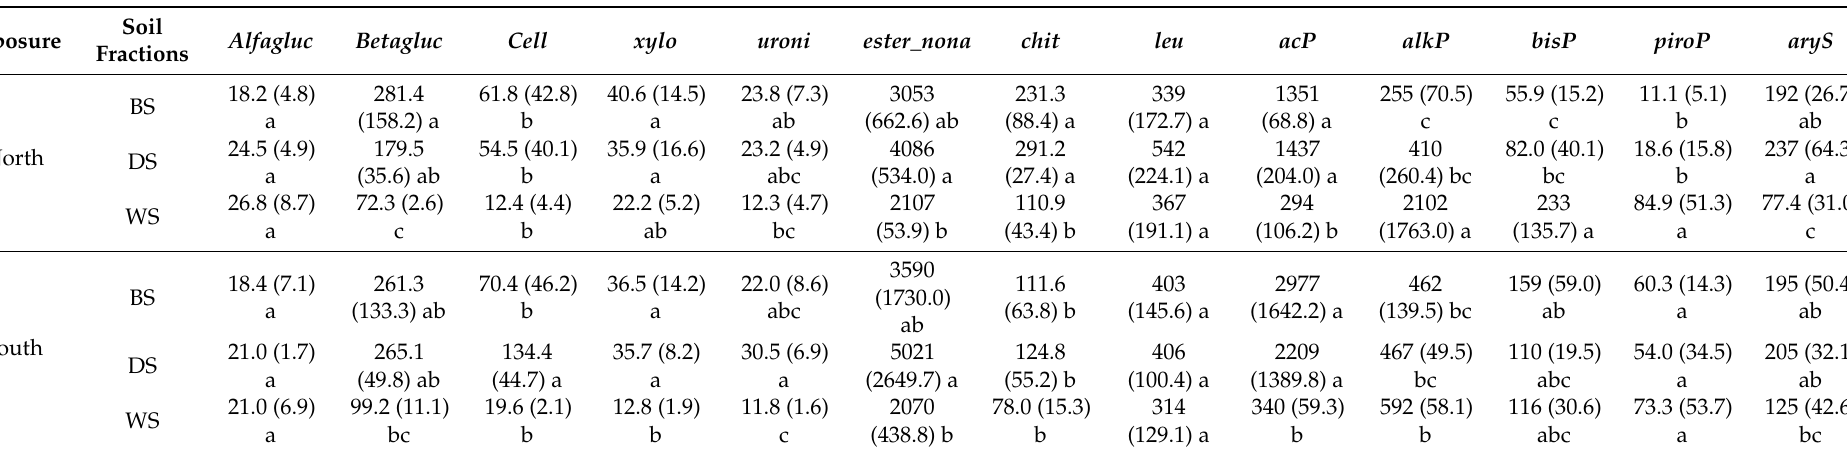
Table 2. Overview of the potential enzymatic activities observed in the bulk soil and the aggregate size fractions (dry-sieved and water-stable 1.00–0.50 mm) in the organic (OF) horizon at the north- and the south-facing sites. Values are means ( n = 3) with the standard deviations in brackets. Data are expressed as nanomoles